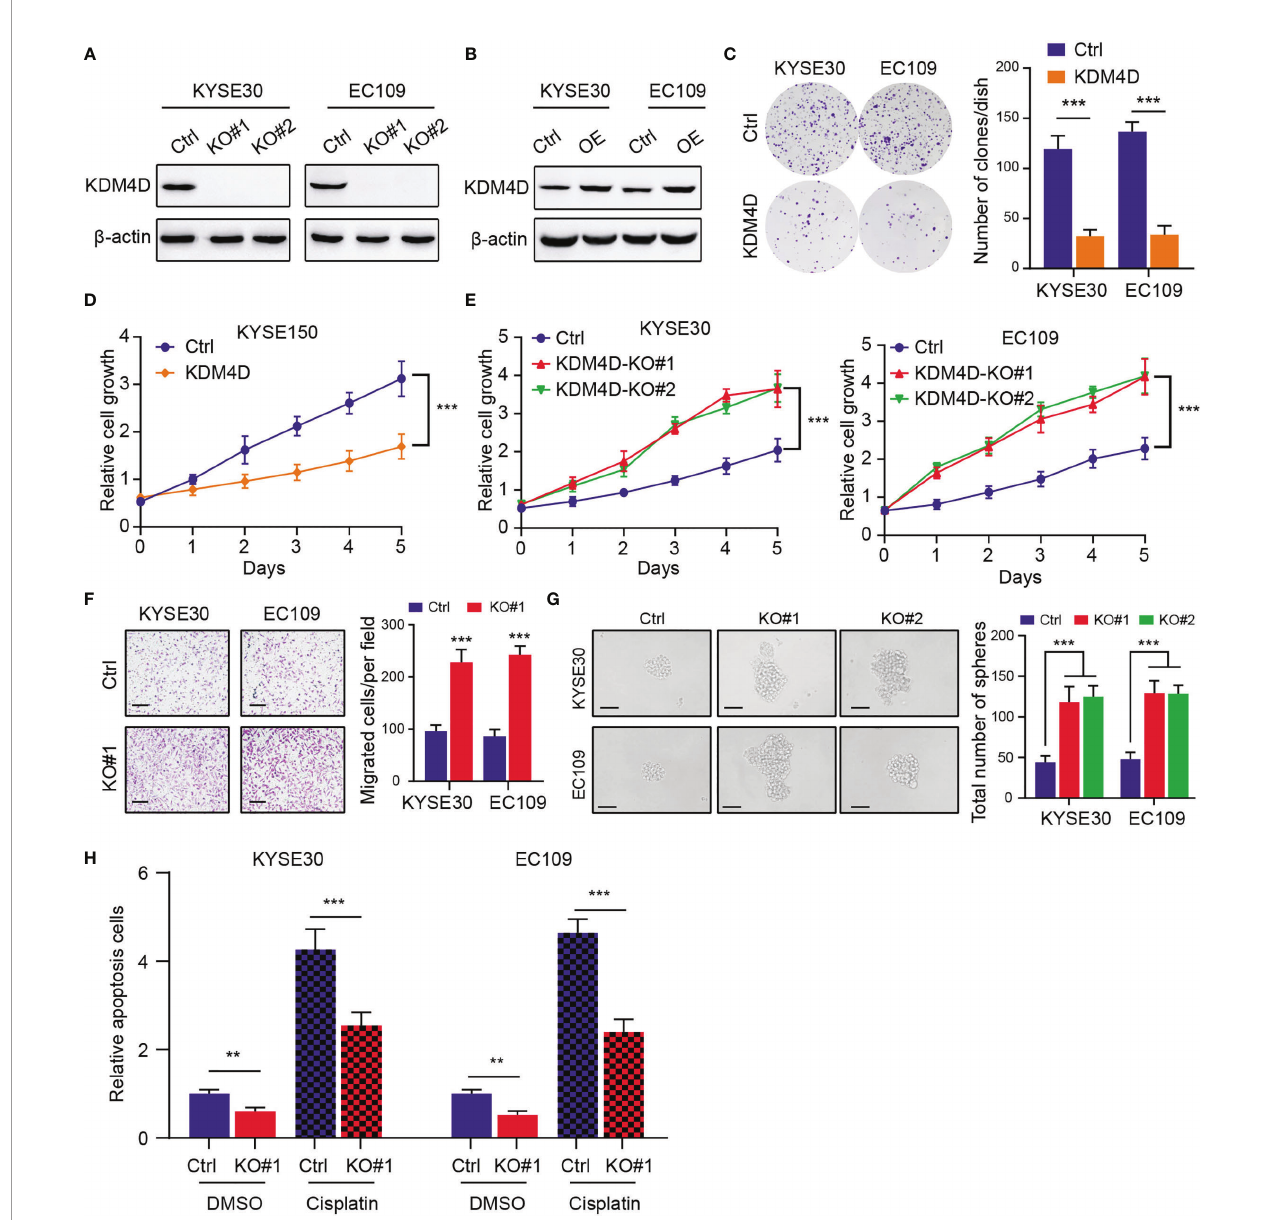
FIGURE 3 | KDM4D inhibition promotes tumor progression and chemotherapy resistance. (A) Western blot revealing the knockout ef fi ciency of KDM4D inKYSE30 and EC109. (B) Western blot exhibiting the overexpression of KDM4D in KYSE30 and EC109. (C) Overexpression of KDM4D suppressed the colony-formation ability of ESCC cells (left panel). Quanti fi cation of the colony formation assay results (right panel). (D) CCK-8 assays showing the difference of growth rate in Ctrl and KDM4D-overexpressing cells. (E) CCK-8 assays comparing the growth differences in Ctrl and KDM4D-KO cells. (F) KDM4D de fi ciency promoted the migrated ability of KYSE60 and EC109 cells (left panel). Quanti fi cation of the Transwel assay results (right panel). (G) Knockout of KDM4D induced the increase in sphere numbers and sizes of ESCC (KYSE30 and EC109) cells relative to the corresponding control cells (left panel); Quanti fi cation of results from the sphere formation assays. (H) Apoptosis rates were detected in cells treated with DMSO and cisplatin. * P < 0.05, ** P < 0.01, *** P <